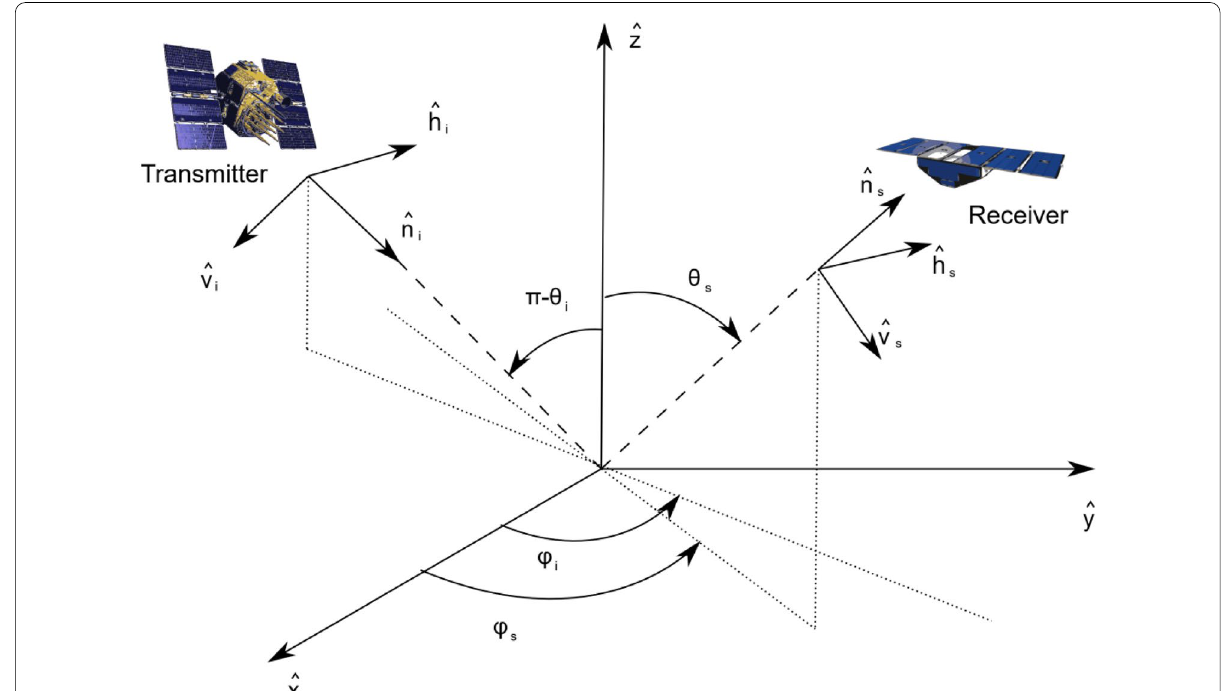
Fig. 1 Bistatic scattering geometry in SoOp-R. A GNSS satellite on the left and a CYGNSS satellite on the right